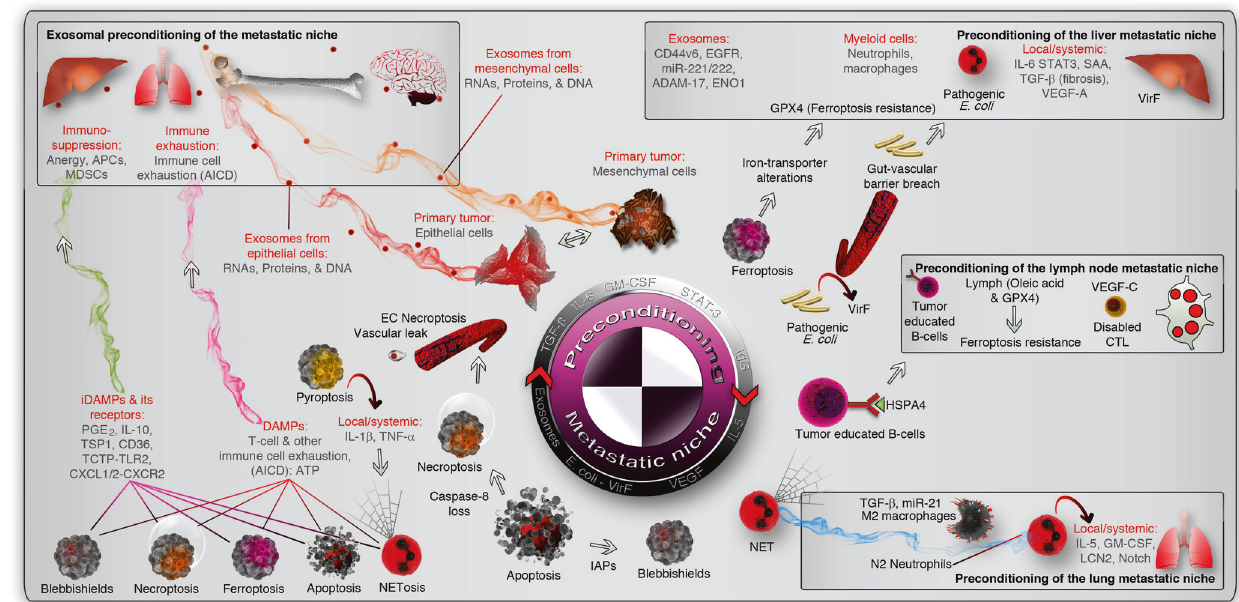
Fig. 4 Preconditioning of the metastatic niche. The epithelial and mesenchymal cells precondition the metastatic niche (marked by inset boxes) by cytokine or chemokine secretion or primarily through exosomes (red and orange smoky trails, respectively. The liver, lymph node, and lung metastatic niche were shown as examples (inset boxes). Microbial preconditioning of the liver niche is shown as an example (pathogenic vir-F containing E. coli ), and exosomal and immunological preconditioning is also shown in the liver niche. In the lymph node niche, tumor-educated immune cells (B-cells exposed to HSPA4 from tumors) or VEGF-C induced exhaust of cytotoxic T- cells (CTLs) or lymph- protected tumor cells serve as preconditioning mediators (non-exhaustive list of mechanisms). In the lungs, polarized immune cells (into pro- tumor) precondition the niche by cytokines and lipocalin-2 (LCN2). In the cell death context, DAMPs or iDAMPs induce cytotoxic immune cell exhaustion by AICD or immunosuppression, respectively (magenta and green smoke trails, respectively). AICD activation-induced cell death, EC necroptosis endothelial cell necroptosis, MDSCs myeloid-derived suppressor cells, APCs antigen-presenting cells, PGE 2 prostaglandin-E 2 , TSP1 thrombospondin-1, TLR2 Toll-like receptor-2, IAPs inhibitor of apoptotic proteins, NET neutrophil extracellular